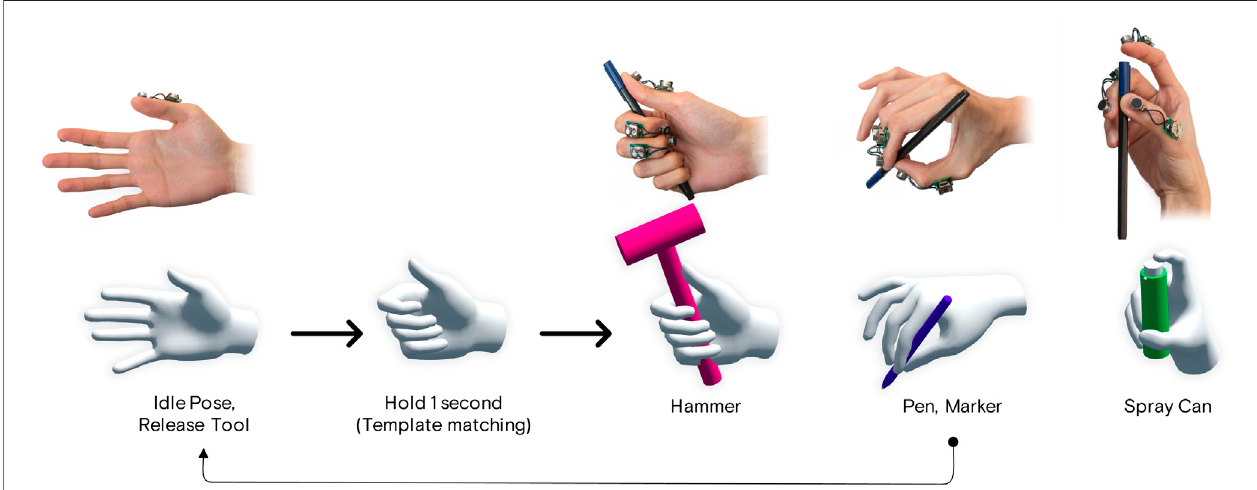
FIGURE6| Anillustration ofthetoolactivationsystem.Theuserstartswithanopen handandholdsthedesired poseforeach toolfor1 s.Theusercanalsoholda physical proxy of the tool in the hand. After 1 s, a tool is visually rendered in the virtual hands and the haptic rendering system augments any interaction of the tool with environment. To release a tool, the user fully opens their hand for 1 s. Switching between tools requires the user to release the current tool fi rst.